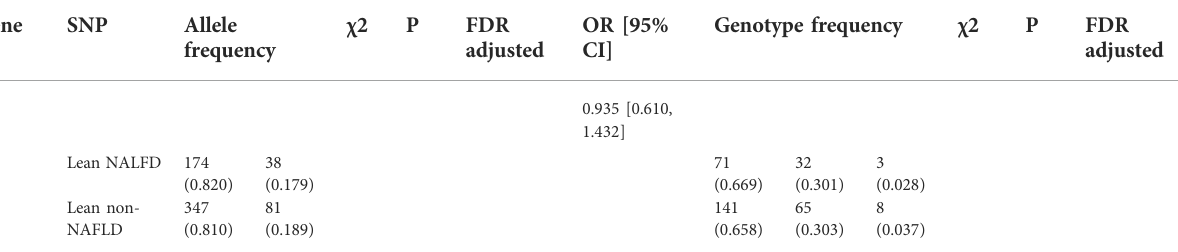
TABLE 3 ( Continued ) Analyzed genes allele and genotype distribution in lean individuals.